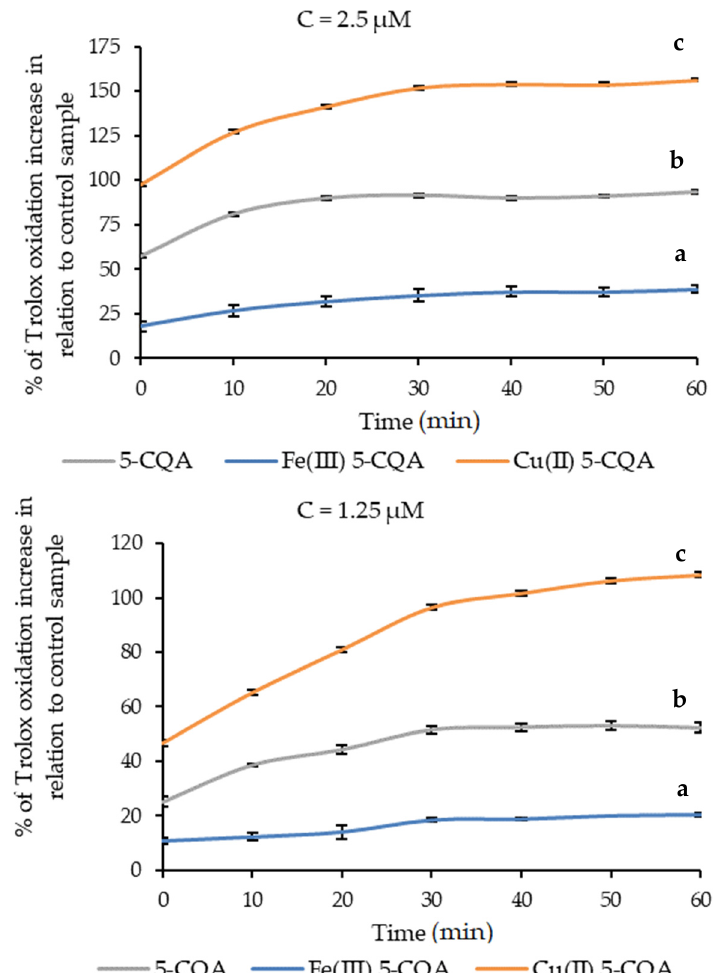
Figure 12. Pro-oxidation activity assay of 5-CQA, Cu(II) 5-CQA, and Fe(III) 5-CQA (2.5; 1.25 µ M). Mean values from three independent experiments ± SDs are shown. The same letter near the means indicates no significant difference (Tukey’s test, p < 0.05).